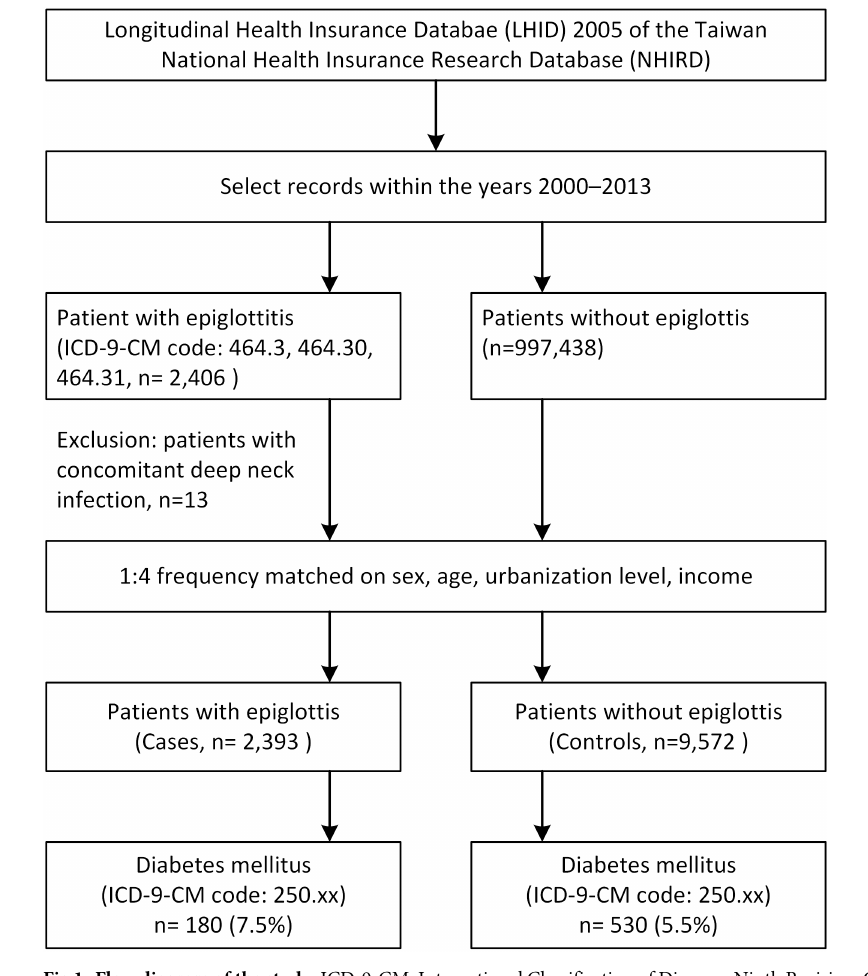
Fig 1. Flow diagram of the study. ICD-9-CM. International Classification of Diseases, Ninth Revision, Clinical Modification.